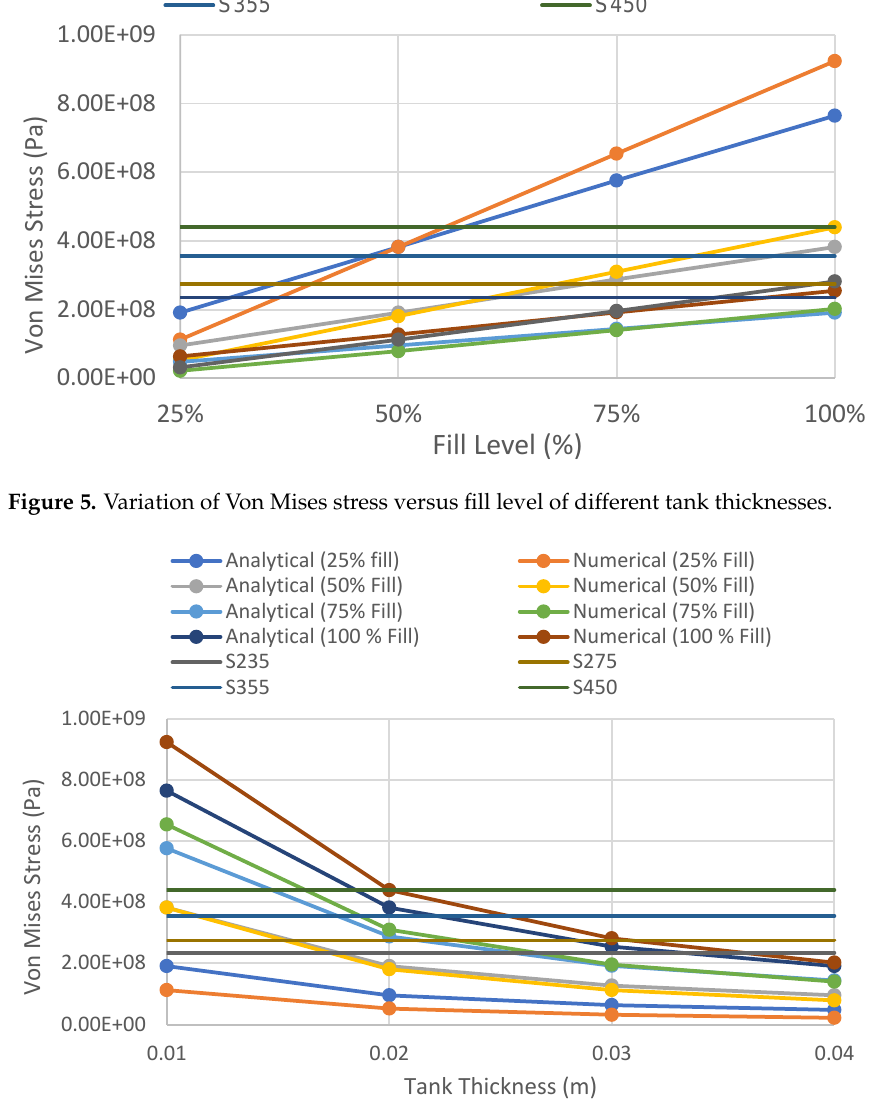
Figure 6. Variation of Von Mises stress versus tank thickness of different fill levels.